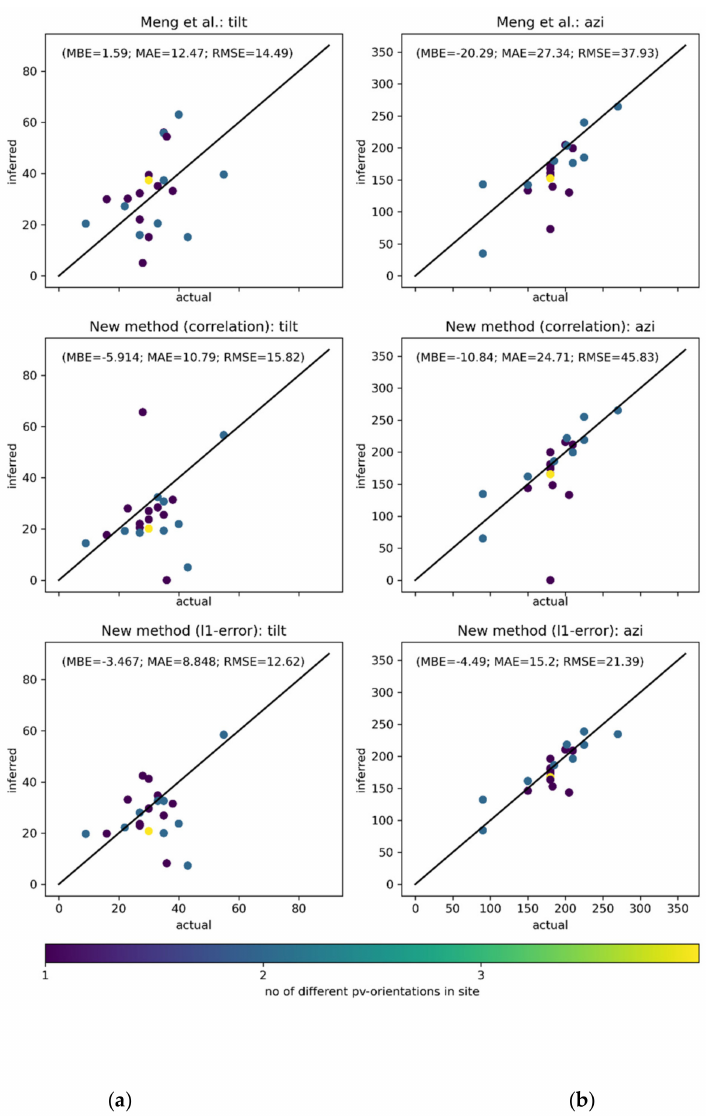
Figure 4. Results from the estimation of panel geometries for different methods: ( a ) tilt and ( b )